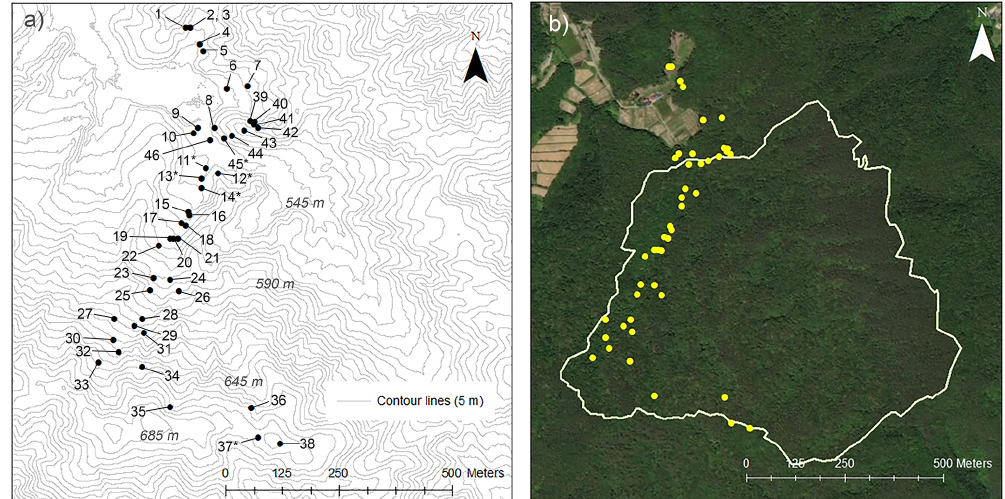
Figure 3. Study site topography and aerial images. (a) Numbered sample locations where multi-year samples were collected at the locations marked by ∗ and contour lines are at 5m intervals (Basemap: ESRI). (b) A large basin enclosing the longest slope (Basemap: